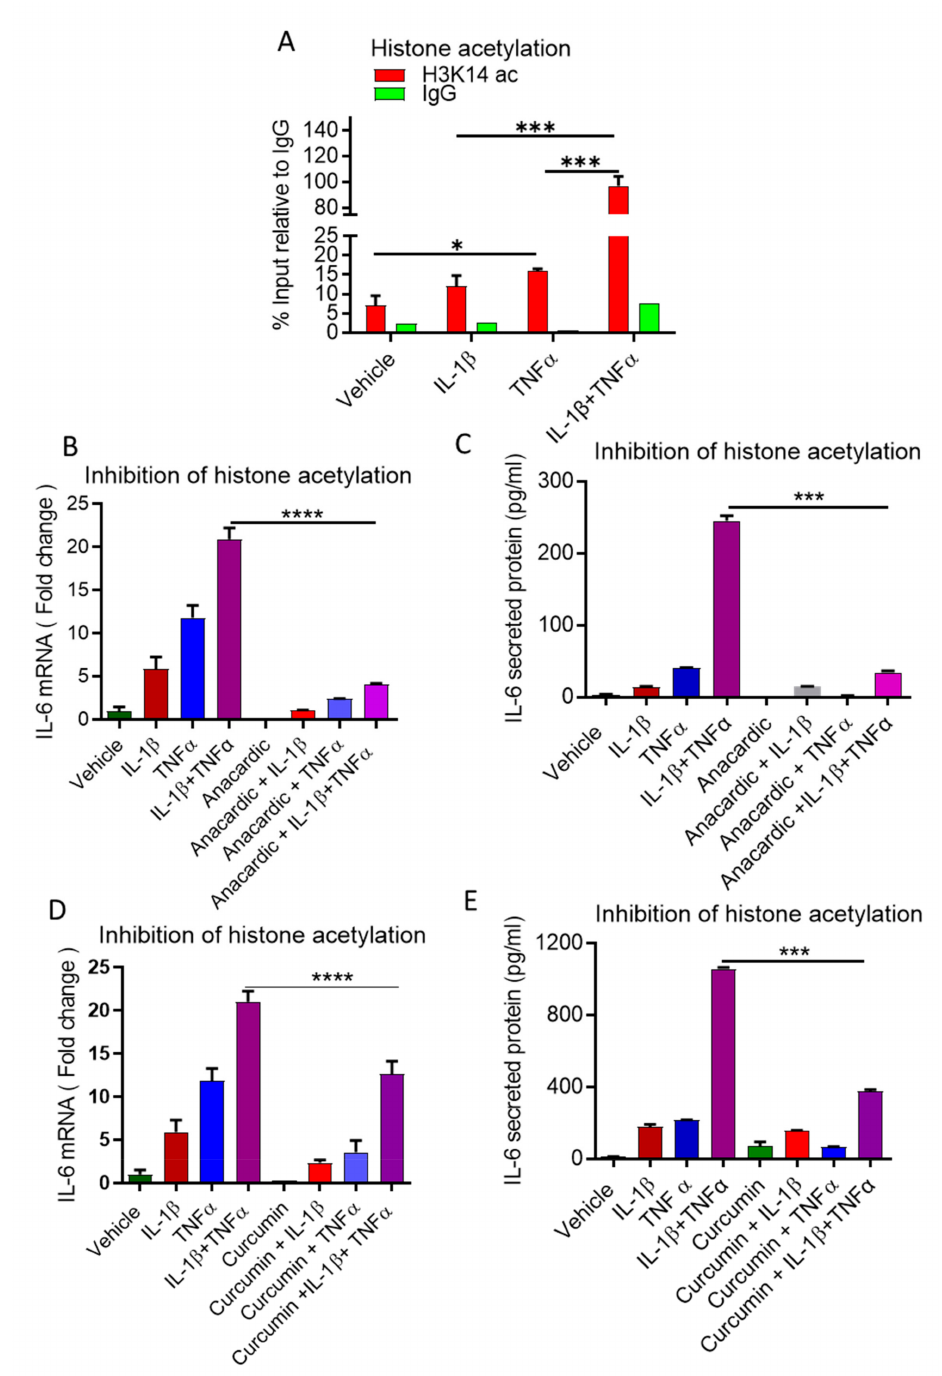
Figure 4. Combined treatment of IL-1 β and TNF α increased H3K14 acetylation. ( A ) 3T3-L adipocytes were incubated with vehicle, IL-1 β and TNF α , alone or in combination, for 5 h. Histone acetylation at IL-6 promoter was determined by analyzing chromatin that was immunoprecipitated with anti-acetylated histone H3 lysine14 (H3K14ac) or IgG (as a control) antibody. Levels of histone modifications were measured using PCR primers for IL-6 proximal promoter ( B , C ) 3T3-L1 adipocytes were incubated with anacardic acid (HATs inhibitor; 4 µ M) for 1 h, followed by the stimulation with IL-1 β , TNF α or IL-1 β /TNF α for 24 h. IL-6 mRNA and secreted protein were determined by qRT-PCR and ELISA, respectively. ( D , E ) 3T3-L1 adipocytes were incubated with curcumin (HATs inhibitor; 20 µ M) for 2 h, followed by stimulation with IL-1 β , TNF α or IL-1 β /TNF α for 24 h. IL-6 mRNA and secreted protein were determined by qRT-PCR and ELISA, respectively. Data are expressed as mean ± SEM ( n = 3). * p < 0.05, *** p < 0.001, **** p <